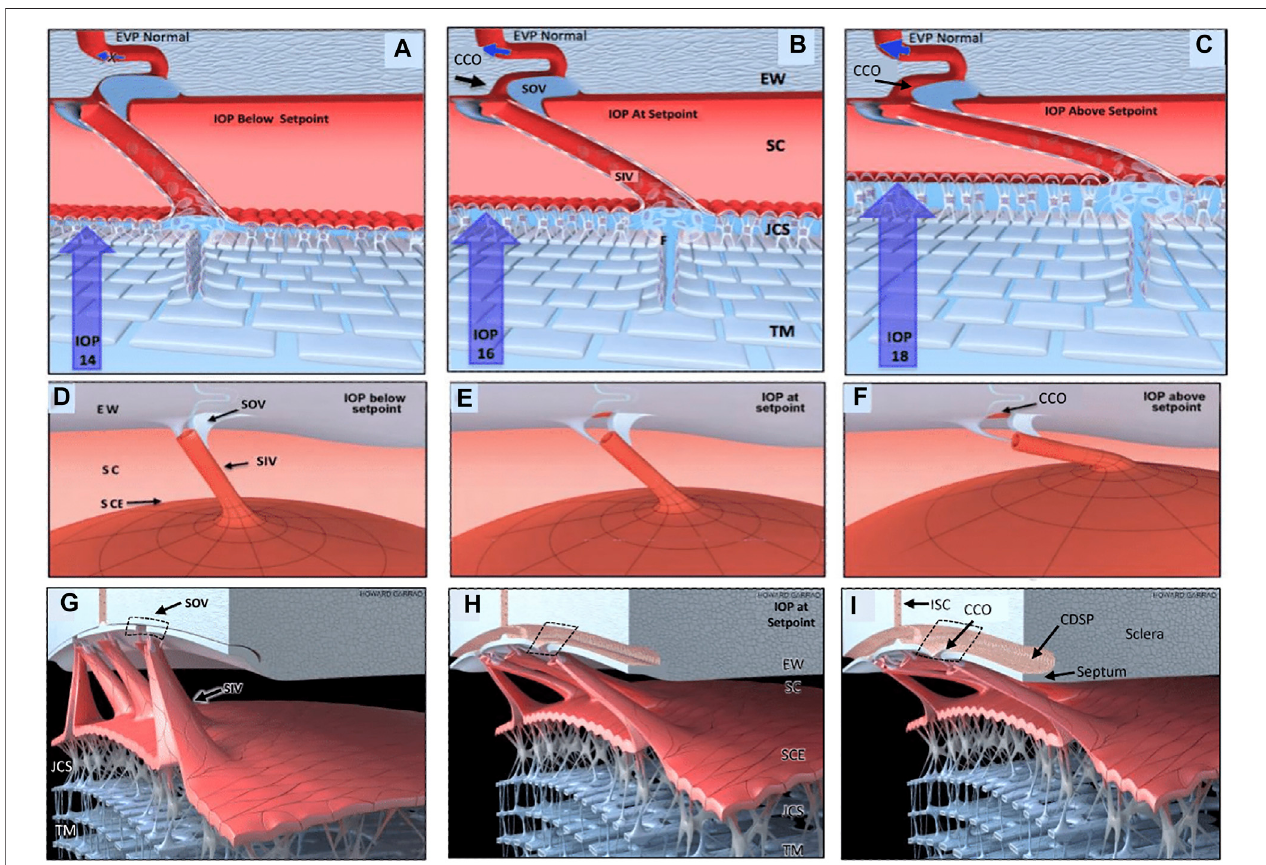
FIGURE 11 | Depiction of the trabecular meshwork, Schlemm ’ s canal, and valve-like structure ’ s pressure-dependent relationships. Images (A,D,G) depict intraocular pressure (IOP) below a homeostatic setpoint, (B,E,H) at the setpoint, and (C,F,I) above the setpoint. In this provisional model, aqueous passes through the trabecular meshwork (TM) to the juxtacanalicular region (JCR) and then fl ows through Schlemm ’ s canal (SC) inlet valves (SIV) into the SC lumen at collector channel entrances or ostia (CCO) present at the SC external wall (EW). An SC outlet valve (SOV) consists of a mobile fl ap-like septum between SC and a circumferentially oriented deep intrascleral vascular plexus (CDSP). The SOV act as mobile fl aps or lea fl ets at CCO. SIV connections to the TM provide a mechanism for pressure- dependent TM motion to control CCO dimensions. The SIV are oriented circumferentially in SC so that an intraocular pressure (IOP) increase that forces the TM into SC pulls the SOV open. The central column (B,E,H) depicts an IOP of 16 mm Hg as the optimal setpoint. An IOP of 14, below the setpoint, closes the CCO and SOV, while anIOPof18morewidelyopensthem,providingamechanicalIOP-dependentcontrolmechanism.Theproposedmodelisbasedonveri fi ableevidenceofSIV,SOV,and their motion in human eyes. However, the proposed regulatory mechanism is provisional, and its premises are subject to modi fi cation or rejection as new evidence emerges Supplementary Video S4.